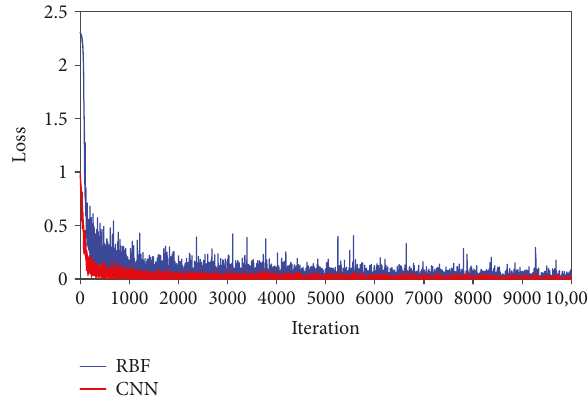
Figure 5: The loss comparison between CNN and